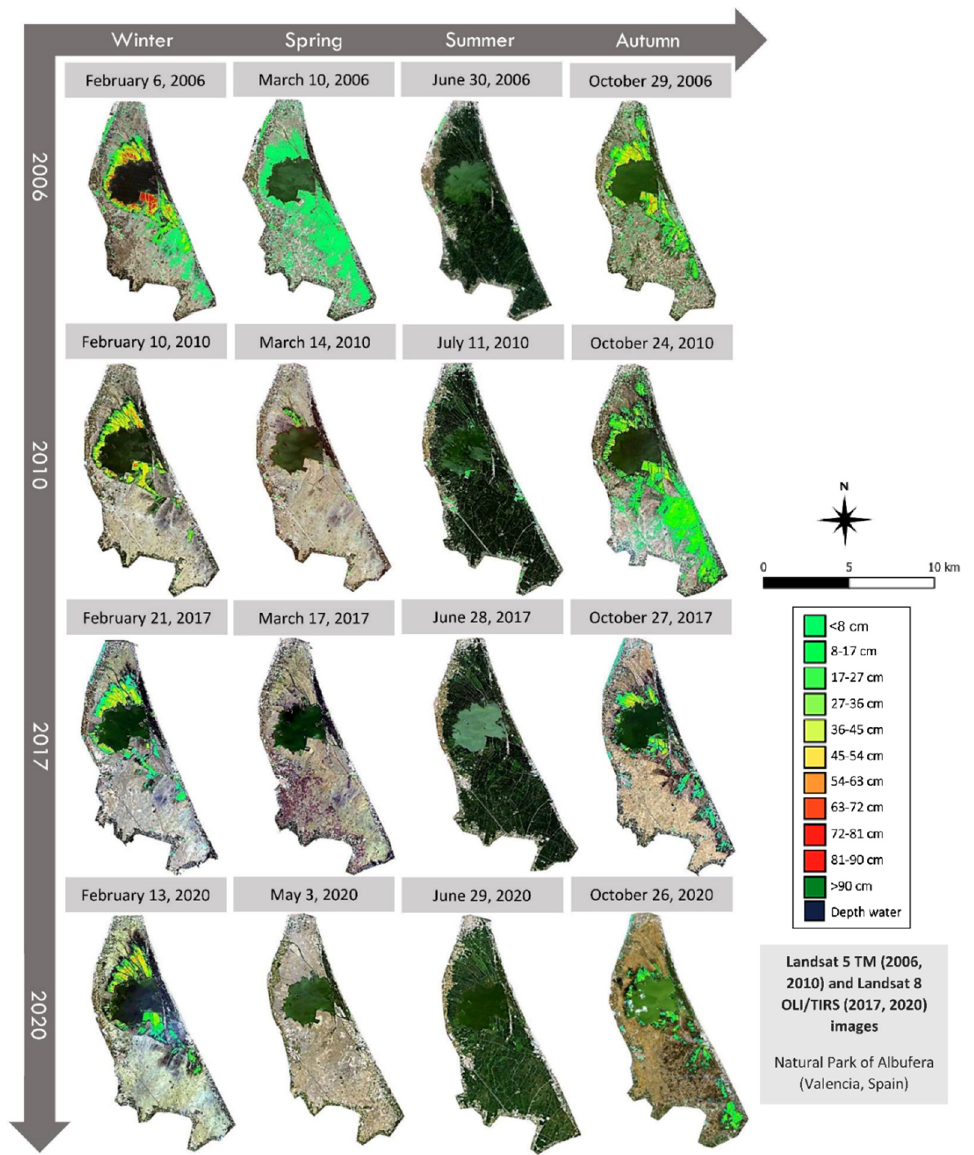
Figure 3. Landsat images from 2006, 2010, 2017 and 2020, corrected and processed by the NDWI index, selected as examples of the seasonal changes taking place in the Natural Park of Albufera. The colors are indicative of the estimated water level derived from the adapted algorithm.